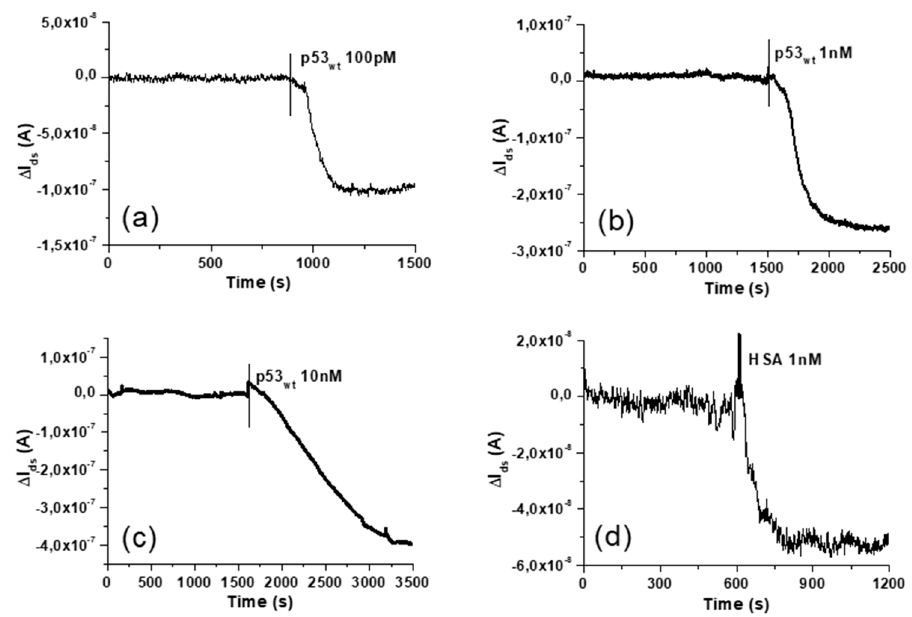
Figure 5. Real time acquisitions of the n-type MOSFET drain-source current I ds (subtracted by the starting value) in different biosensing experiments, performed in the same conditions (V ds = 100 mV, V ref = 400 mV, working buffer: PBS 100 mM, pH 8.0, starting volume: 350 μ L). ( a – c ) Single injections of 20 μ L of the working buffer with diluted p53 wt , resulting in a final concentration in the fluid cell of 100 pM, 1 nM and 10 nM. ( d ) Single injection of 20 μ L of the working buffer with diluted HSA (1 nM final concentration). Vertical bars indicate the protein injection time.